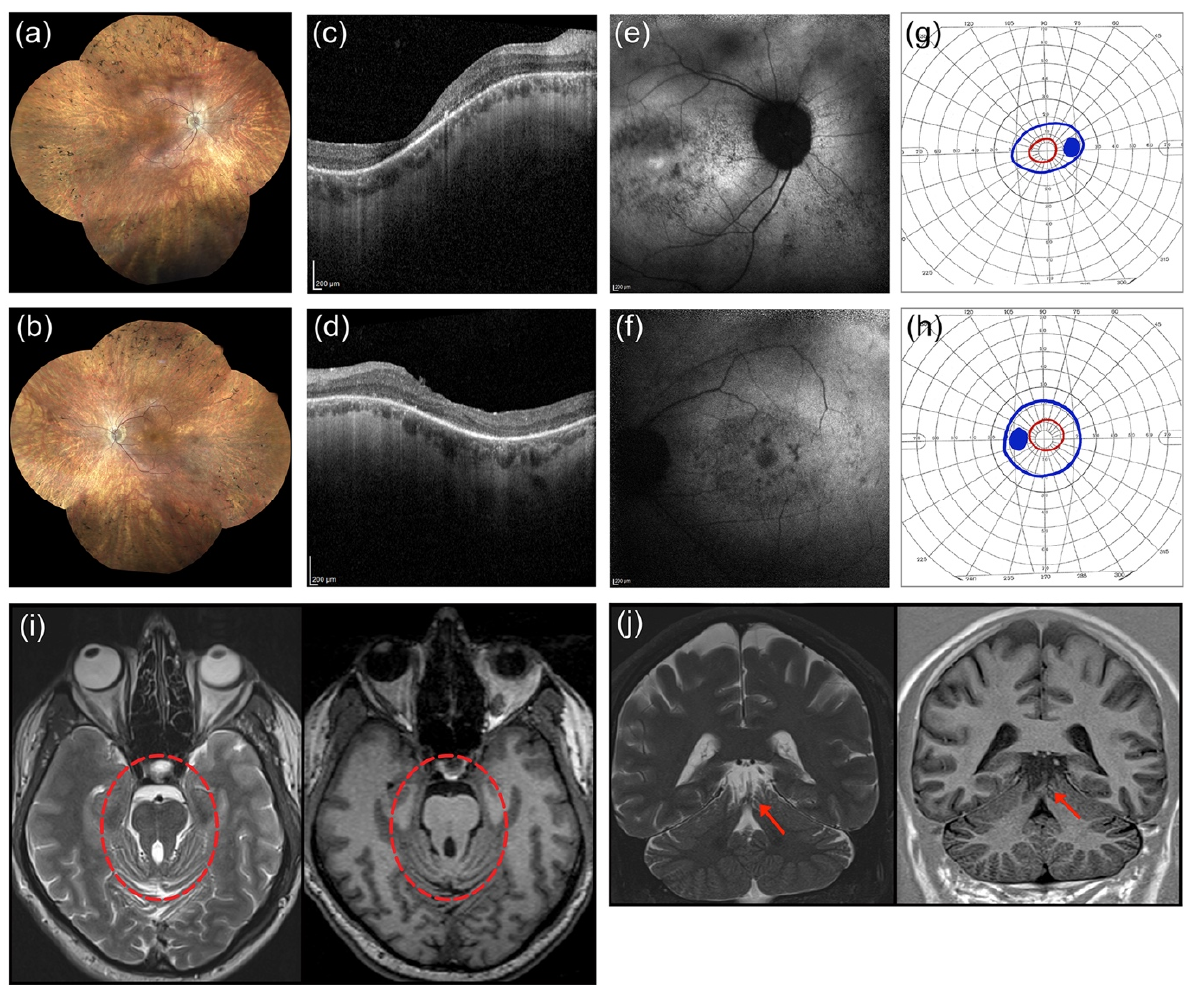
Figure 1. Clinical findings in the proband. Ophthalmological findings in the right eye (RE) are shown in panel ( a , c , e , g ), and in the left eye (LE) in ( b , d , f , h ). Fundus imaging of the proband ( a , b ) revealed a waxy pallor of the optic disc with a circumpapillary atrophy, and widespread dystrophy of the retinal pigment epithelium with bone spicule-shaped pigment deposits in mid-periphery. Optical coherence tomography ( c , d ) showed reduced macular thickness and RPE dystrophy in both eyes and a vitreoretinal interface syndrome in the LE. Fundus autofluorescence imaging ( e , f ) showed focal areas of hypoautofluorescence at the posterior pole with foveal hyperautofluorescence in the RE and foveal hypoautofluorescence in the LE. Visual field tests ( g , h ) showed a bilateral constriction of the III4e (blue color) and V4e isopters field (red color). Axial ( i ) and coronal ( j ) T2- (left side) and T1-weighted (right side) brain MRI images at the level of the upper vermis and mesencephalon. The abnormally thickened and elongated superior cerebellar peduncles resemble the shape of a molar tooth on the axial images (red circle). The severe hypoplasia of the upper part of the cerebellar vermis and the dysplasia of the cerebellar folia is evident on the coronal slices (red arrow).